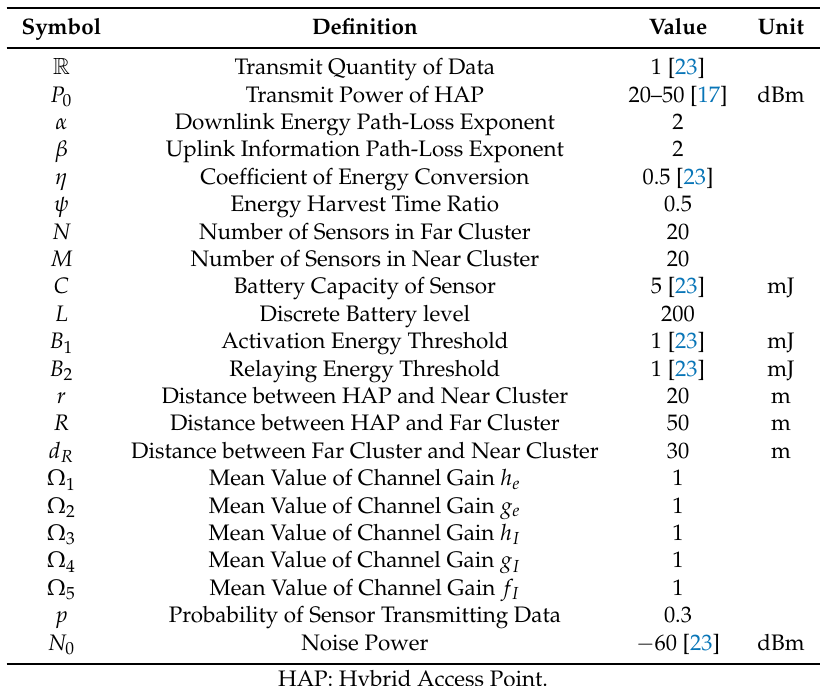
Table 1. Theparamaeters of